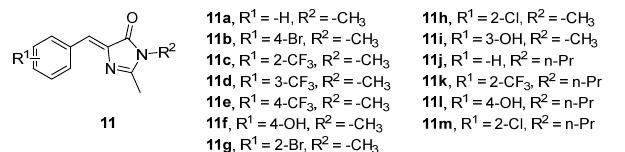
Figure 11. GFPc analogue with enhanced emission when encapsulated in NaCh vesicles [25]. A β -cyclodextrin could mimic the protein environment, and act as a supramolecular host upon inclusion of a GFPc inside its cavity. The fluorescence intensity of a GFPc ana-